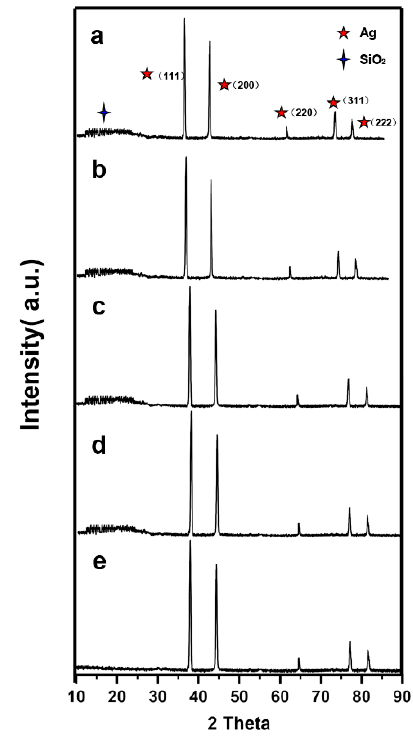
Figure 6. XRD patterns of a, b, c, d and e samples. ( a ) Ag@SiO 2 prepared by CH 2 O before reaction, ( b ) Ag@SiO 2 prepared by C 7 H 6 O at low concentration before reaction, ( c ) Ag@SiO 2 prepared by CH 2 O after reaction, ( d ) Ag@SiO 2 prepared by C 7 H 6 O at low concentration after reaction, ( e ) Ag NPs prepared by CH 2 O without adding tetraethyl orthosilicate